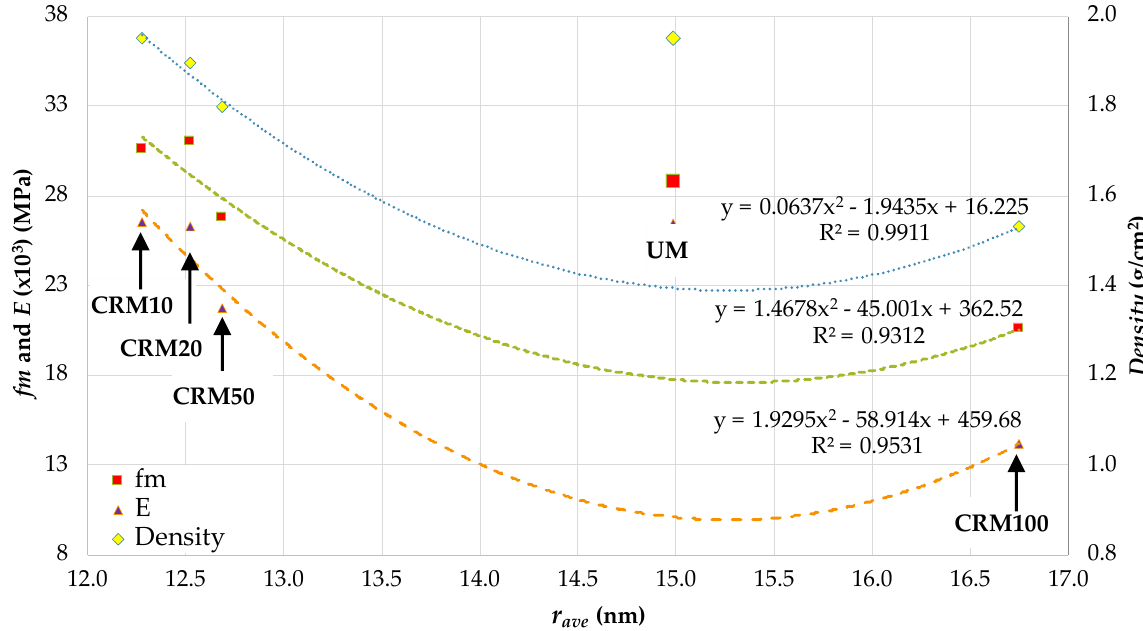
Figure 10. Correlation between fm , E and density , with respect to r ave . The r ave , as an evident representative parameter (central tendency) of the porosity of the CRMs, meets the expectations of its capacity to link the physical-mechanical behavior of the mortars under study to their porosity. Therefore, an increase in r ave is related to losses in fm and density , with CA causing the increase in r ave , which in turn produces a weaker CRM matrix structure. On the other hand, the nature of the type of equation es- tablished (second order polynomial) may suggest the existence of another variable not included in this study, which could be the cause of the nonlinearity in the equation. Fi- nally, the existence of a significant change in the plotting of the curves between the CRM50